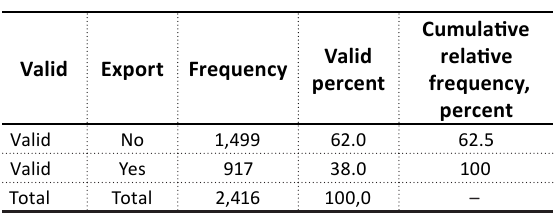
Table 1. Export/non-export activities of family